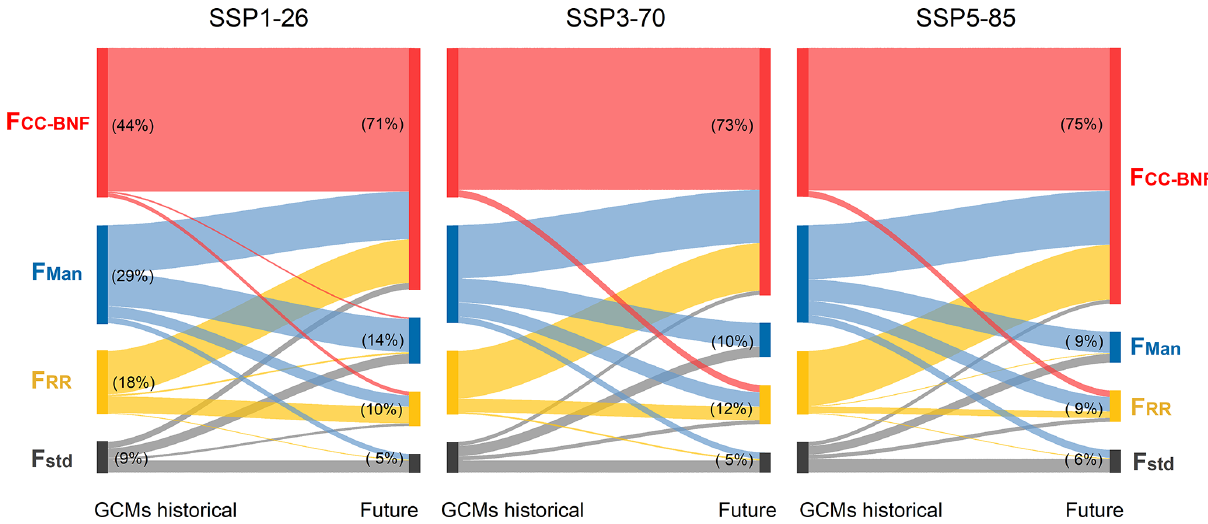
Figure 7. The relative (%) number of cropland grid cells regarding their optimal soil C sequestration practice (Eq. 4) for the historical period (C3, Table 1) and three future SSP scenarios from 2091–2100 (C2, Table 1). The numbers in the figure represent the mean of simulations using five GCMs, and transitions are indicated by the coloured bands. See Table 3 for management